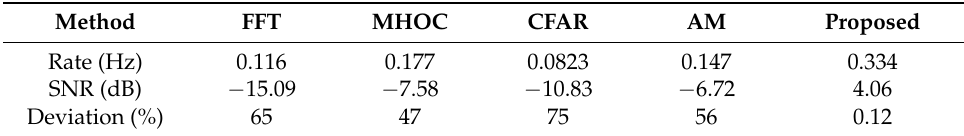
Table 4. Actuator experiment results with five